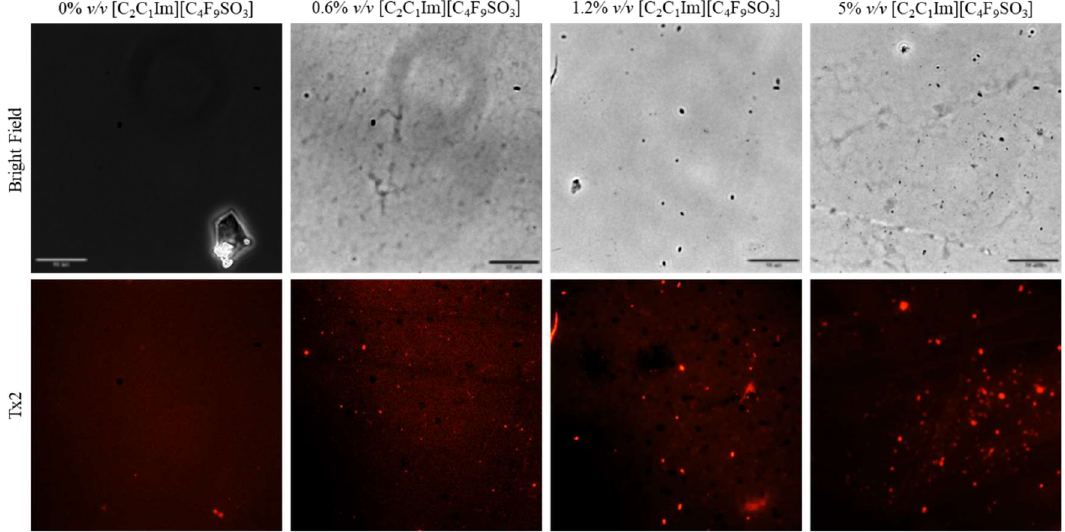
Figure 12. Fluorescence microscopy of Nile Red micelles at 0, 0.6, 1.2, and 5% v / v [C 2 C 1 Im][C 4 F 9 SO 3 ]. Scale bar corresponds to 10 µm.